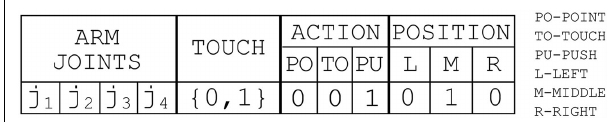
FIGURE 5 |The input vector for theAL module. The agent is in the state of making the push action on the middle object.